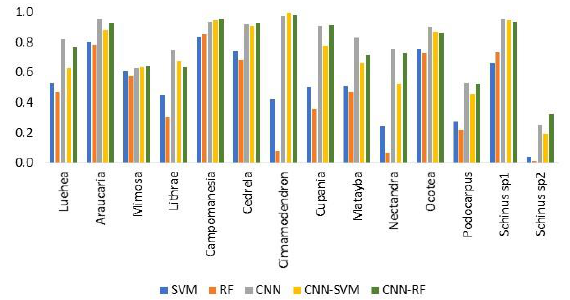
Figure 4. F-measure of each tree species class according to the classifier/approach.